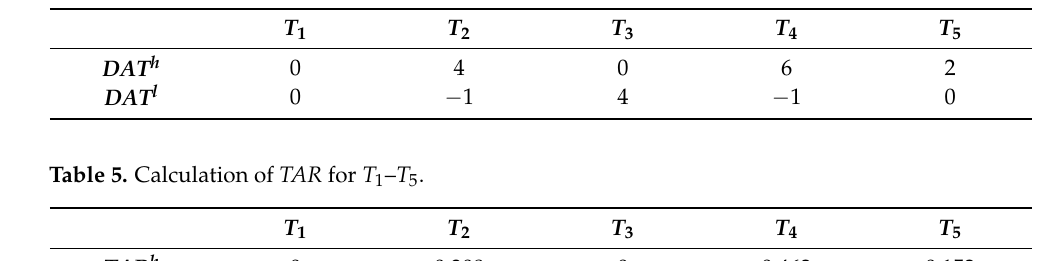
Table 4. Calculation of DAT for T 1 – T 5 .